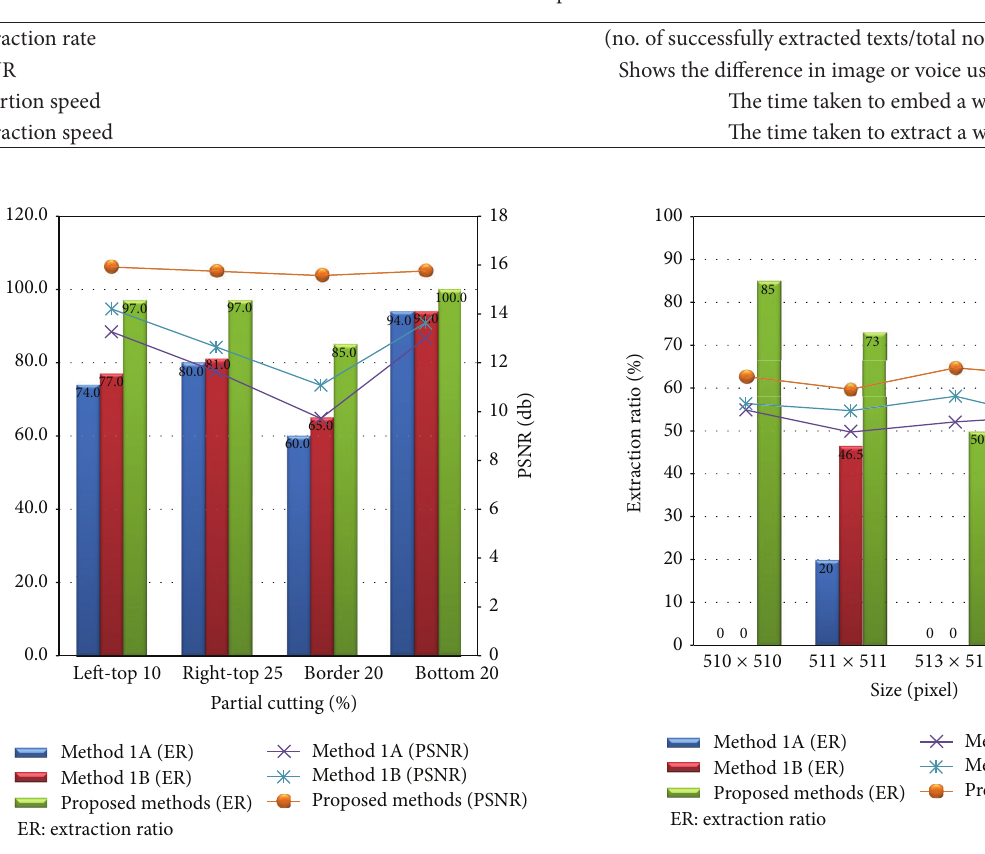
Table 3: Experimental units.